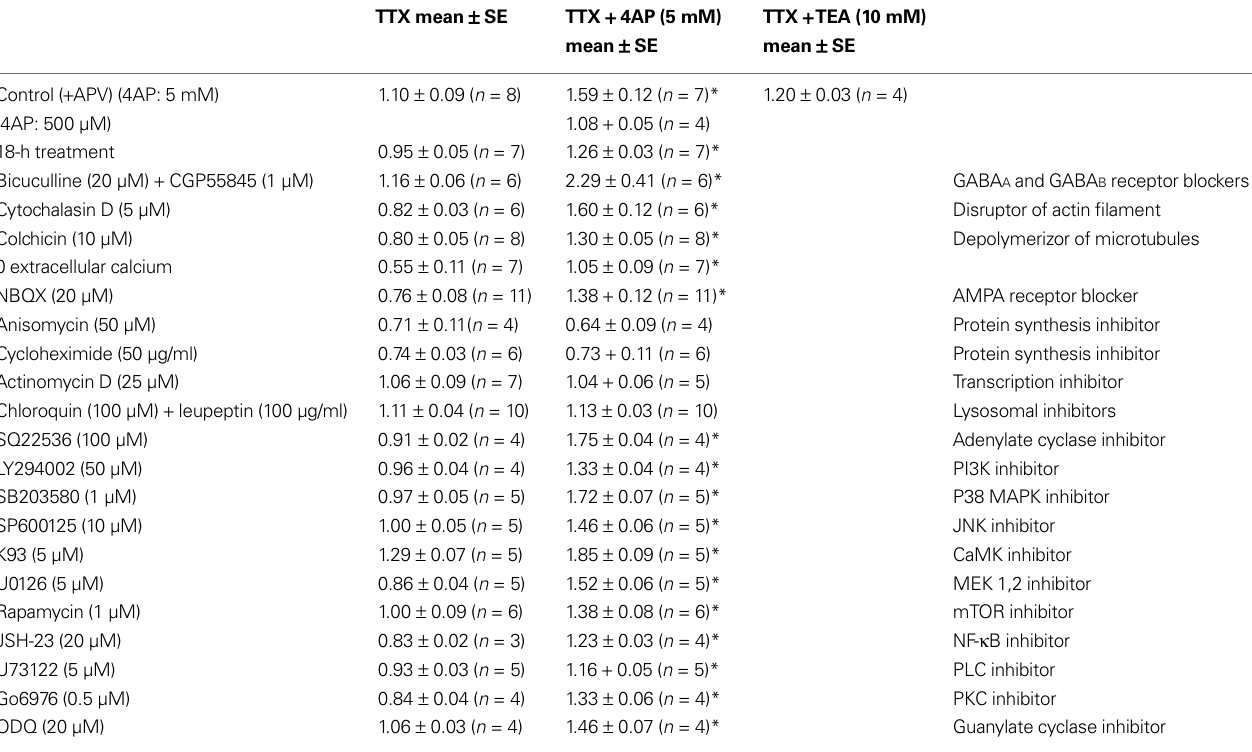
Table 2 | The stratum pyramidale: stratum radiatum immunohistochemical signal ratio of GluR1 after 12-h incubation in the indicated